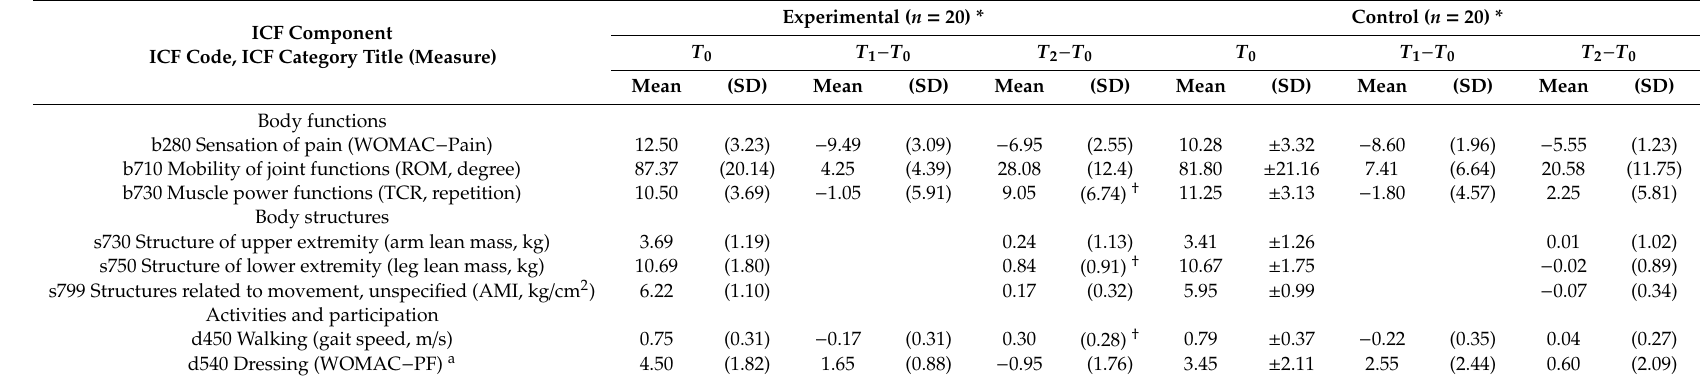
Table 2. Mean changes in outcome variables based on the categories of brief International Classification of Functioning, Disability and Health Core Set for osteoarthritis (Brief-ICF-OA) at time point 1 month after operation ( T 1 ) and 4 months after operation ( T 2) from baseline (before operation ( T 0